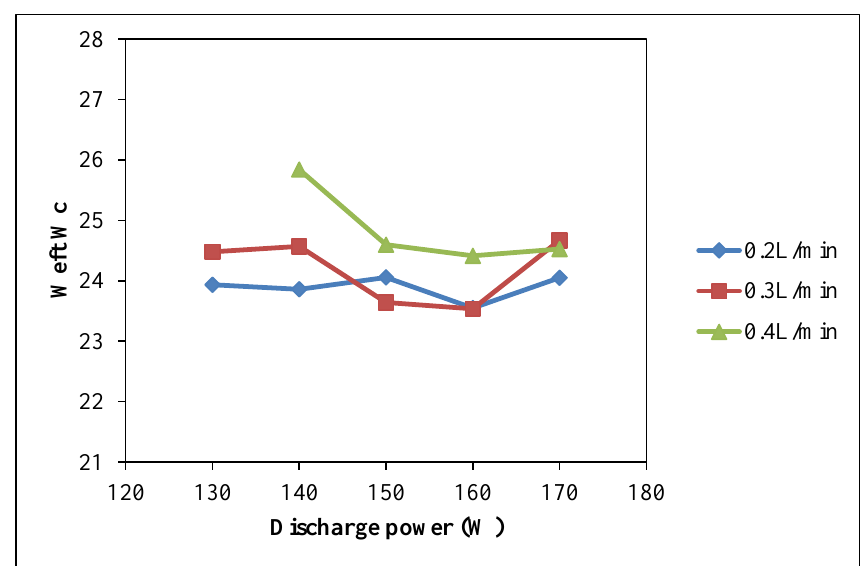
Figure 3. Effect of discharge power on weft W c (Discharge power: 130 W, 140 W, 150 W, 160 W and 170 W; Oxygen flow rate: 0.2 L/min, 0.3 L/min and 0.4 L/min; Jet travelling speed: 5 mm/s and Jet-to-substrate distance: 3 mm).